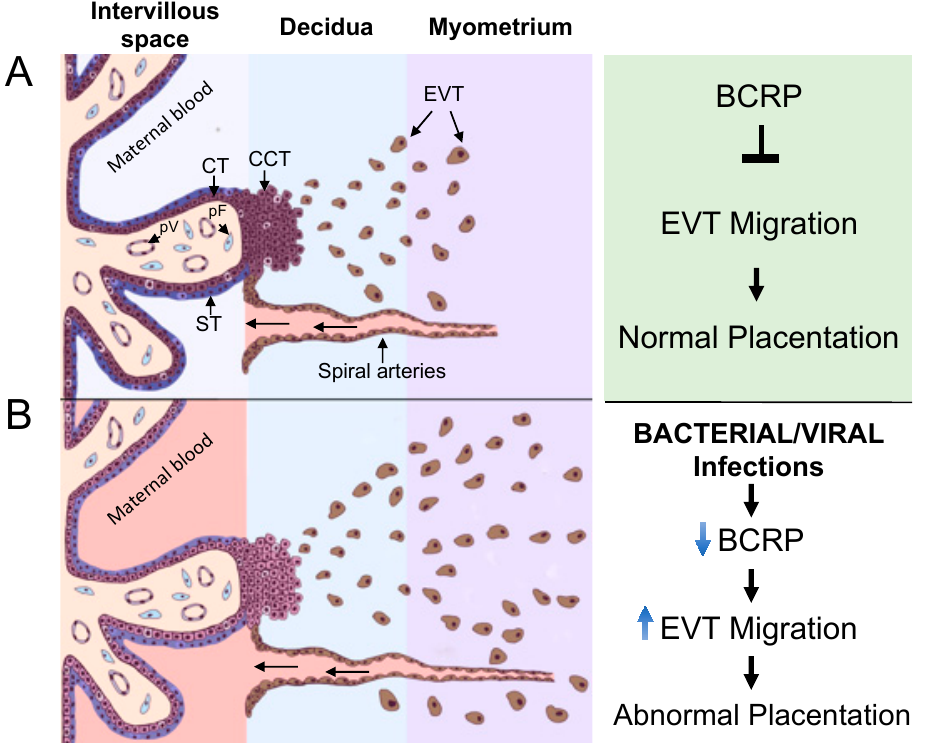
Figure 8. Hypothetical model depicting the impact of bacterial / viral infection mediated downregulation of BCRP on human placentation ( A ) BCRP decrease cell migration and when disrupted by bacterial and viral infections, ( B ) may increase EVT migration and lead to abnormal placentation. Figure S1: Representative Images of cell proliferation assay following si ABCG2 , scrambled siRNA, Ko143 or VEH exposure at 0 and 24 h N = 6, Scale bars = 400 µ m. Figure S2: Representative Images of cell proliferation assay following LPS or ssRNA or VEH exposure at 0 and 24 h. N = 6, Scale bars = 400 µ